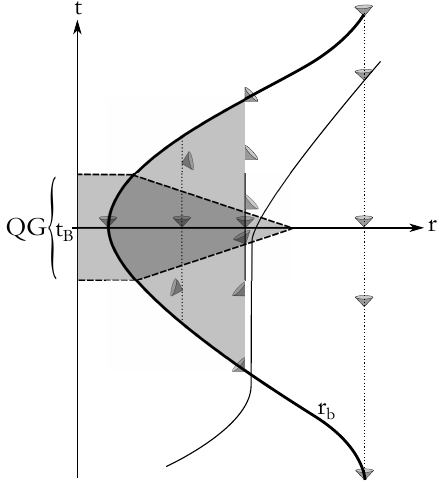
Figure 2. Finkelstein diagram for the black hole to white hole transition. The grey area enclosed within dashed lines represents the region where quantum effects are important (QG). The grey area within solid lines represents the trapped region in the exterior space-time. The solid thick line r b represents the boundary of the cloud. The solid thin vertical line represents the horizon in the exterior region. In this case the transition is completely symmetric in time. The bounce occurs at the same time t B for all shells (as in the homogeneous case). An horizon grazing photon (thin curved line), stays in the vicinity of the horizon until right after t B . The lifetime of the white hole is the same as the lifetime of the black